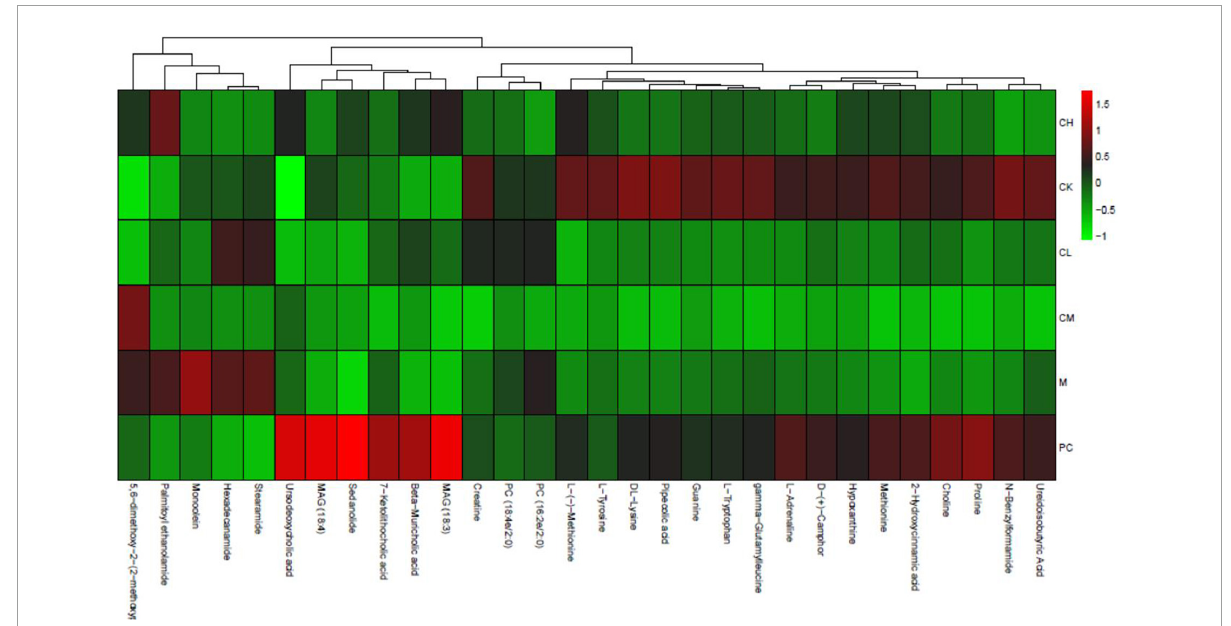
FIGURE10 Metabolite heat map clustering